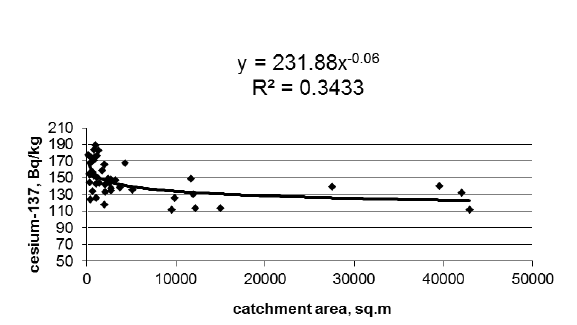
Figure 3. Relationship function for the long modern streams (length above 500 m), correlation coefficient is 0.6